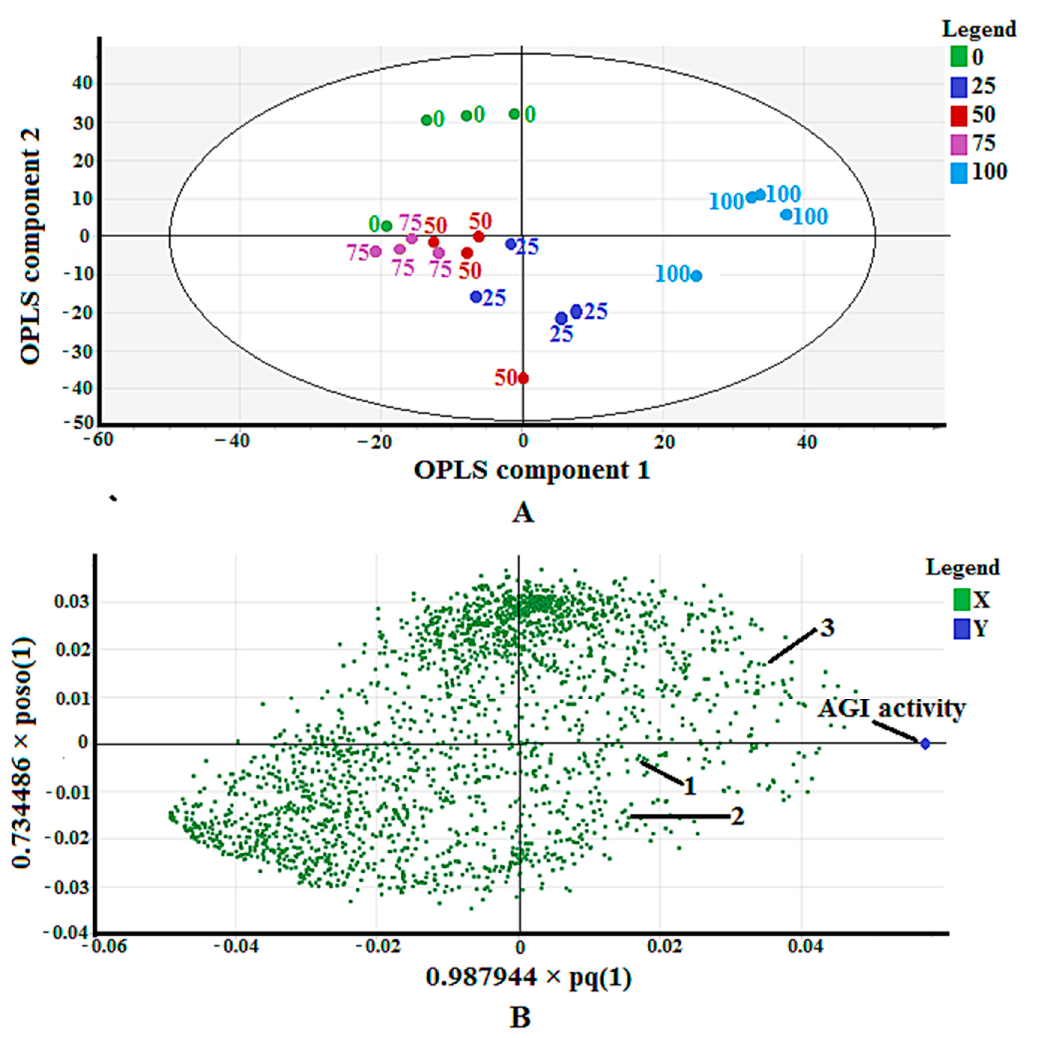
Figure 3. ( A ) Score scatter plot of validated OPLS model for 20 extracts of P. malayana leaves; ( B ) The loading scatter plot of OPLS model.